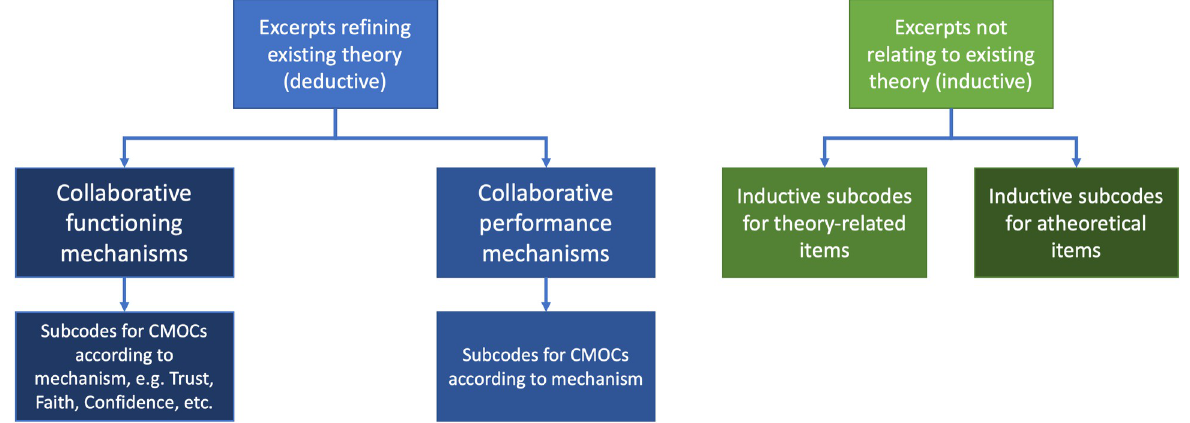
Fig 3. Depiction of the coding framework used in the study. This paper is focused on collaborative functioning mechanisms.